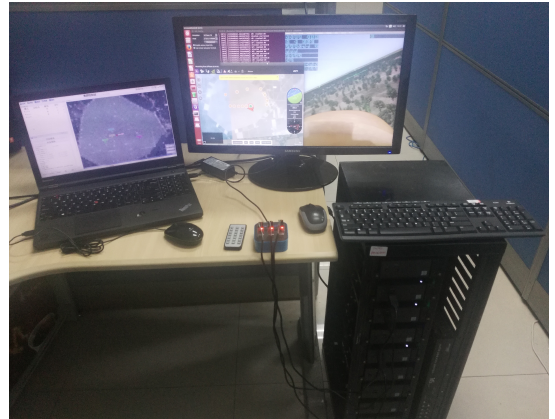
Figure 5. The simulation